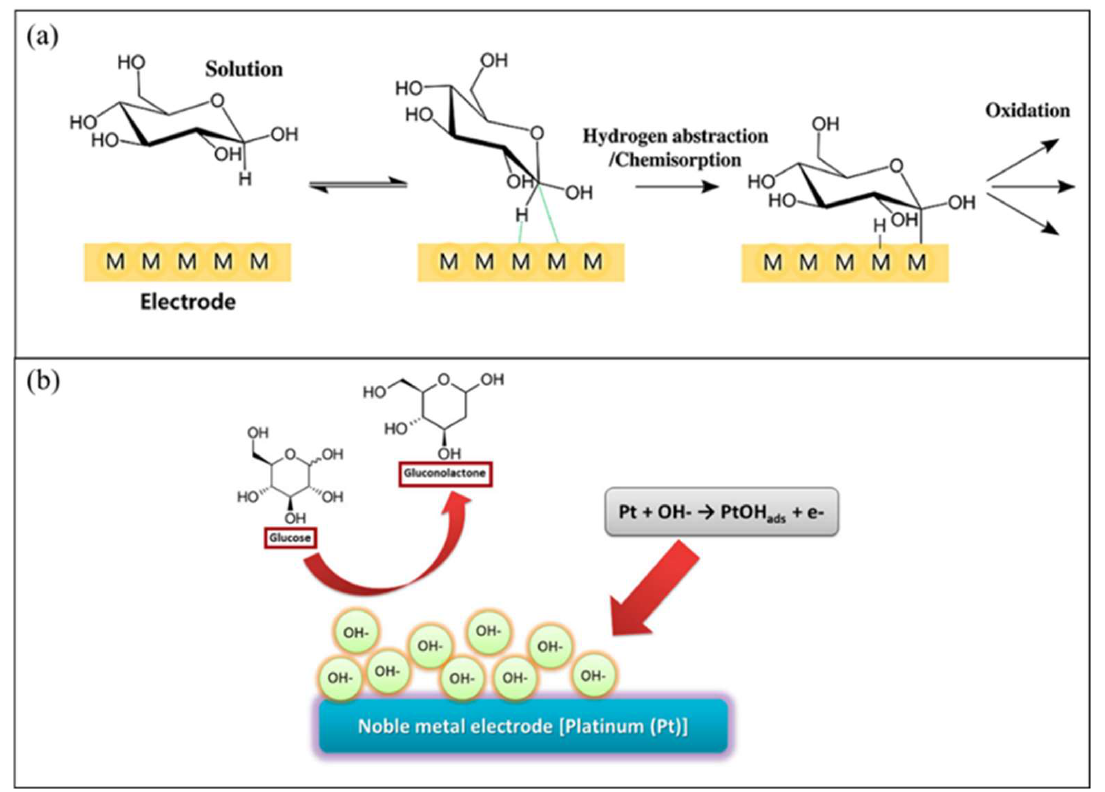
Figure 11. Schematic of ( a ) chemisorption model. Reprinted with permission from ref. [200]; Copy- right 2018 Elsevier. ( b ) IHOAM model of glucose oxidation. Reprinted with permission from ref. [35]; Copyright 2021 Frontiers.